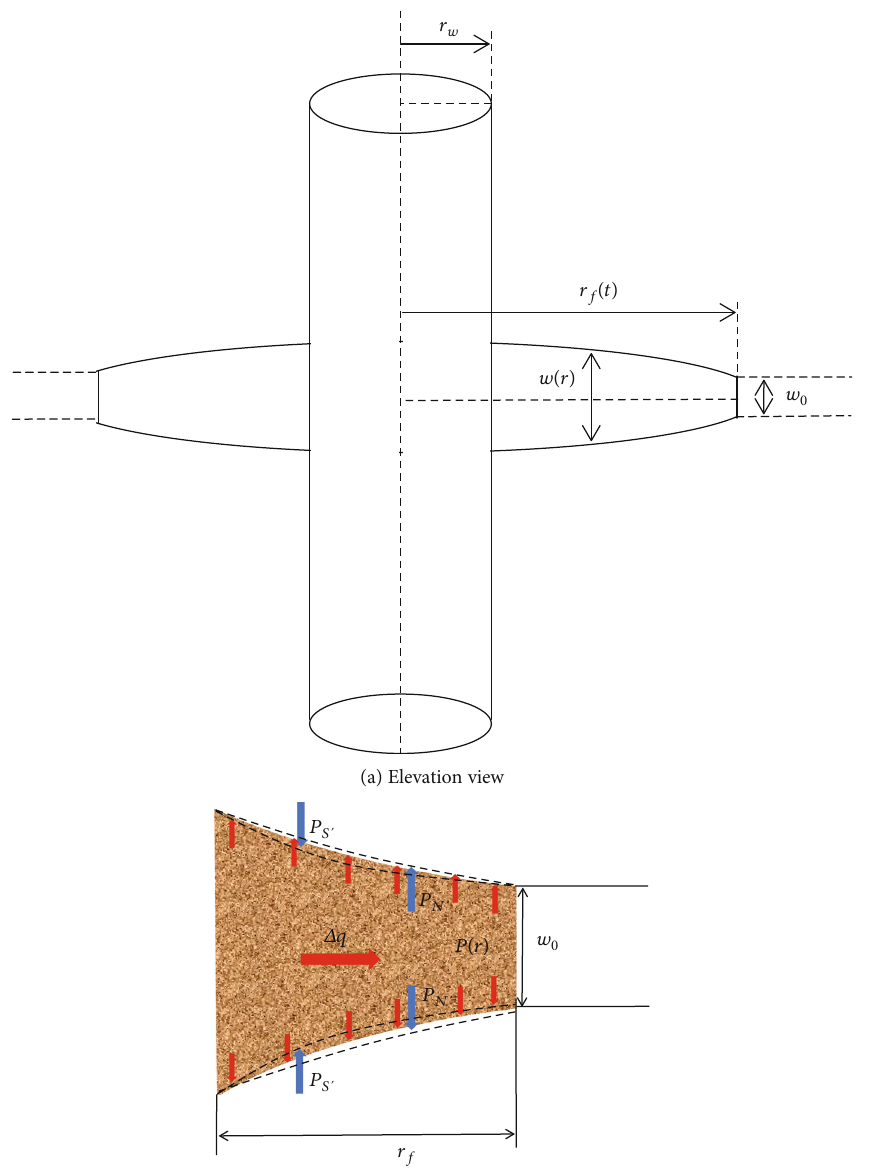
Figure 2: Schematic diagram of fracture inner hydromechanical